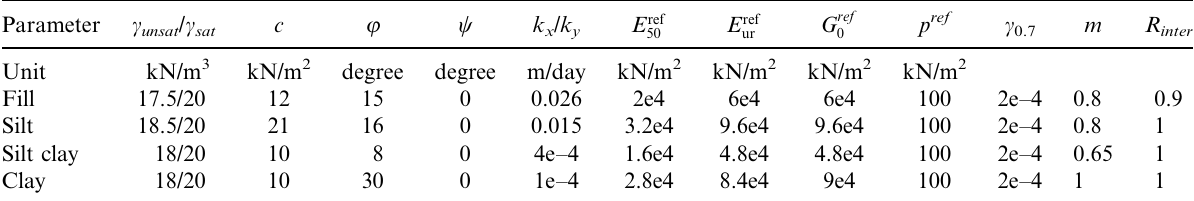
Table 1. Soil properties used for finite element analysis